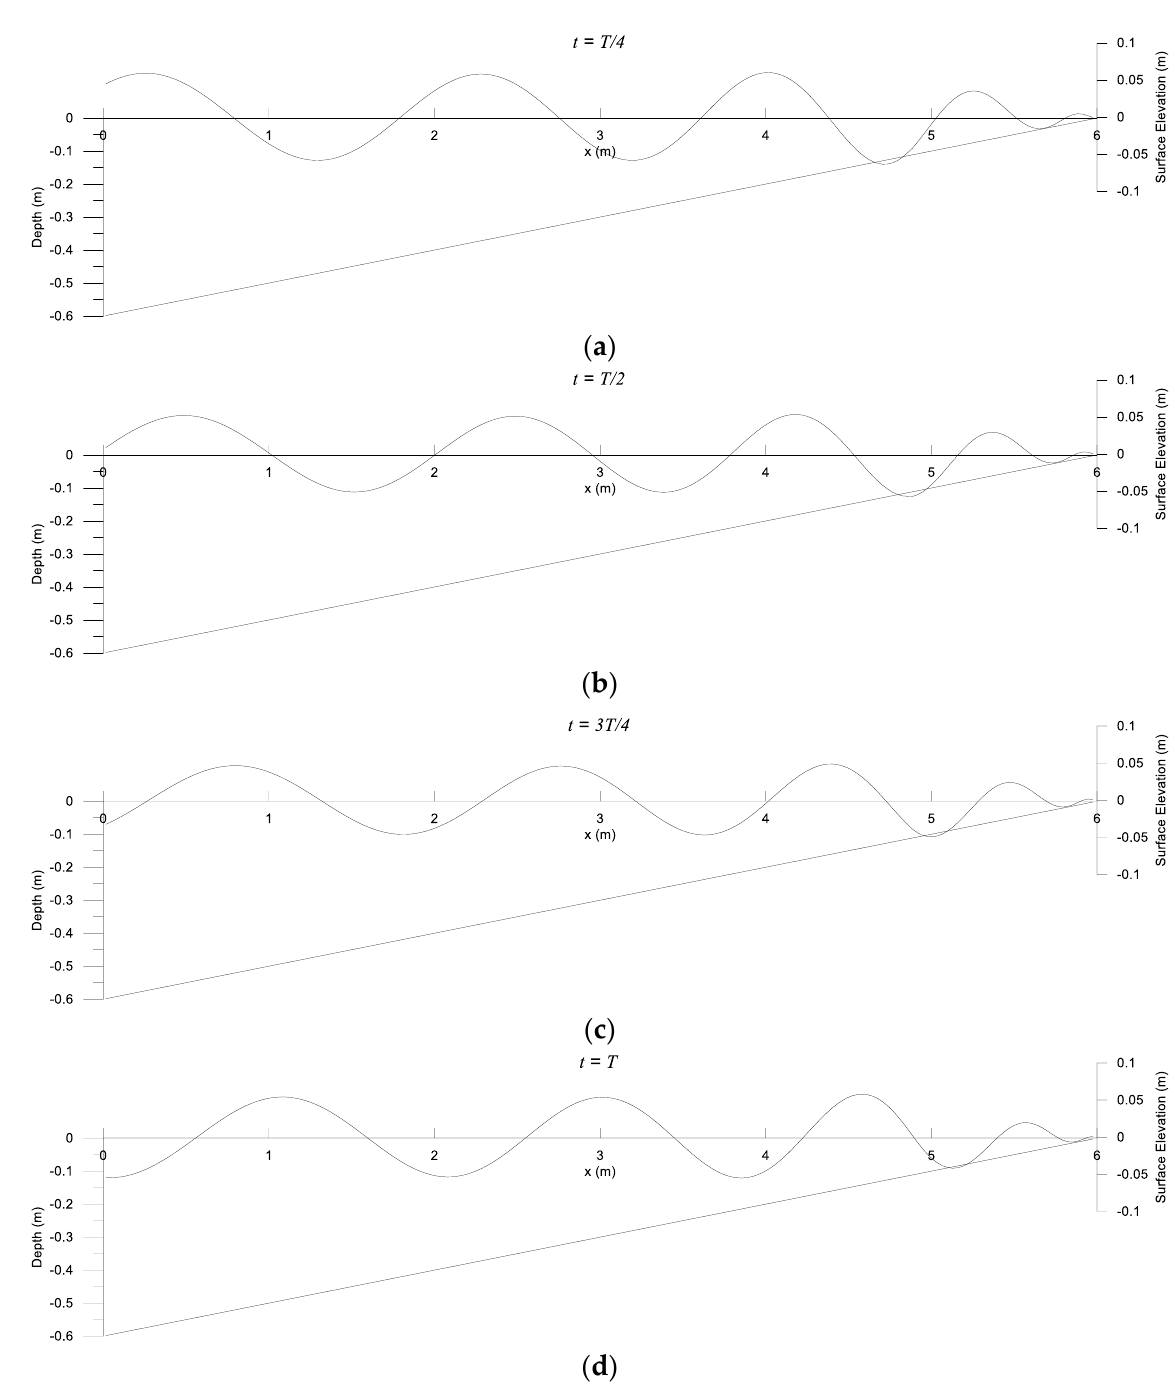
mulas of energy dissipation factors [25,27,28,44].